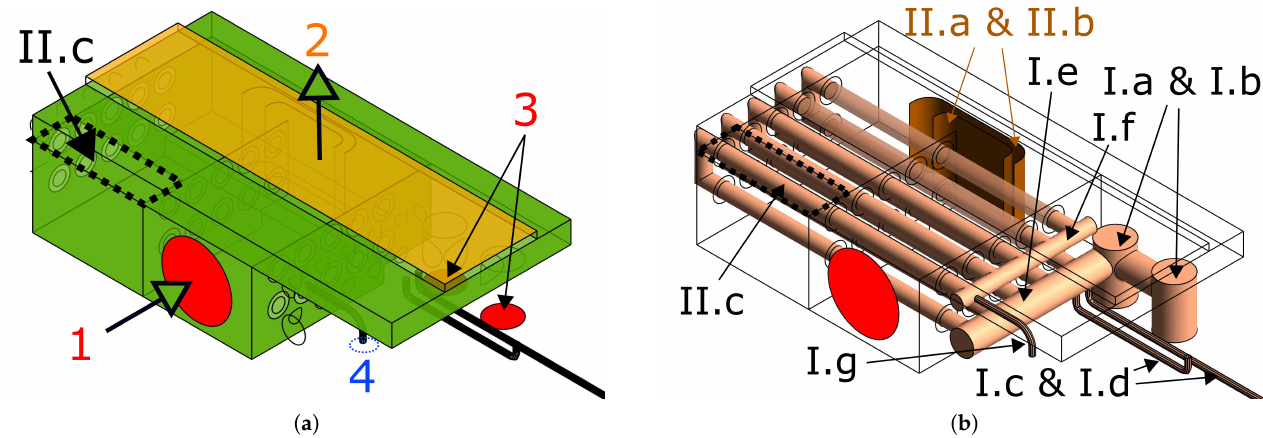
Figure 3. Computational domain: ( a ) air path/zone; ( b ) steam path/zone. 1—air inlet; 2—air outlet; 3—steam inlets; 4—steam exit. I.a & I.b—steam vent; I.c & I.d—water trap; I.e—lower header; I.f—upper header; I.g—air/steam zone connector; II.a and II.b—flow guides; II.c—air